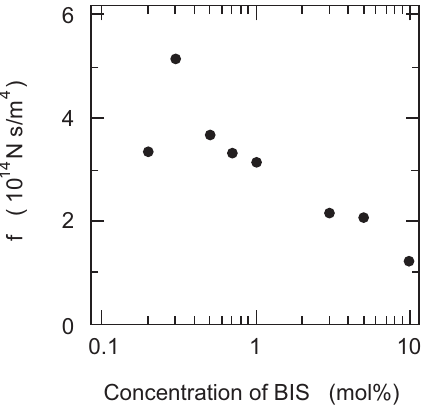
Figure 7. The cross-linker concentration dependence of the friction coefficient of PAAm gel. The total concentration of gel is fixed at 700 mM, and the mole fraction of the cross-linker is